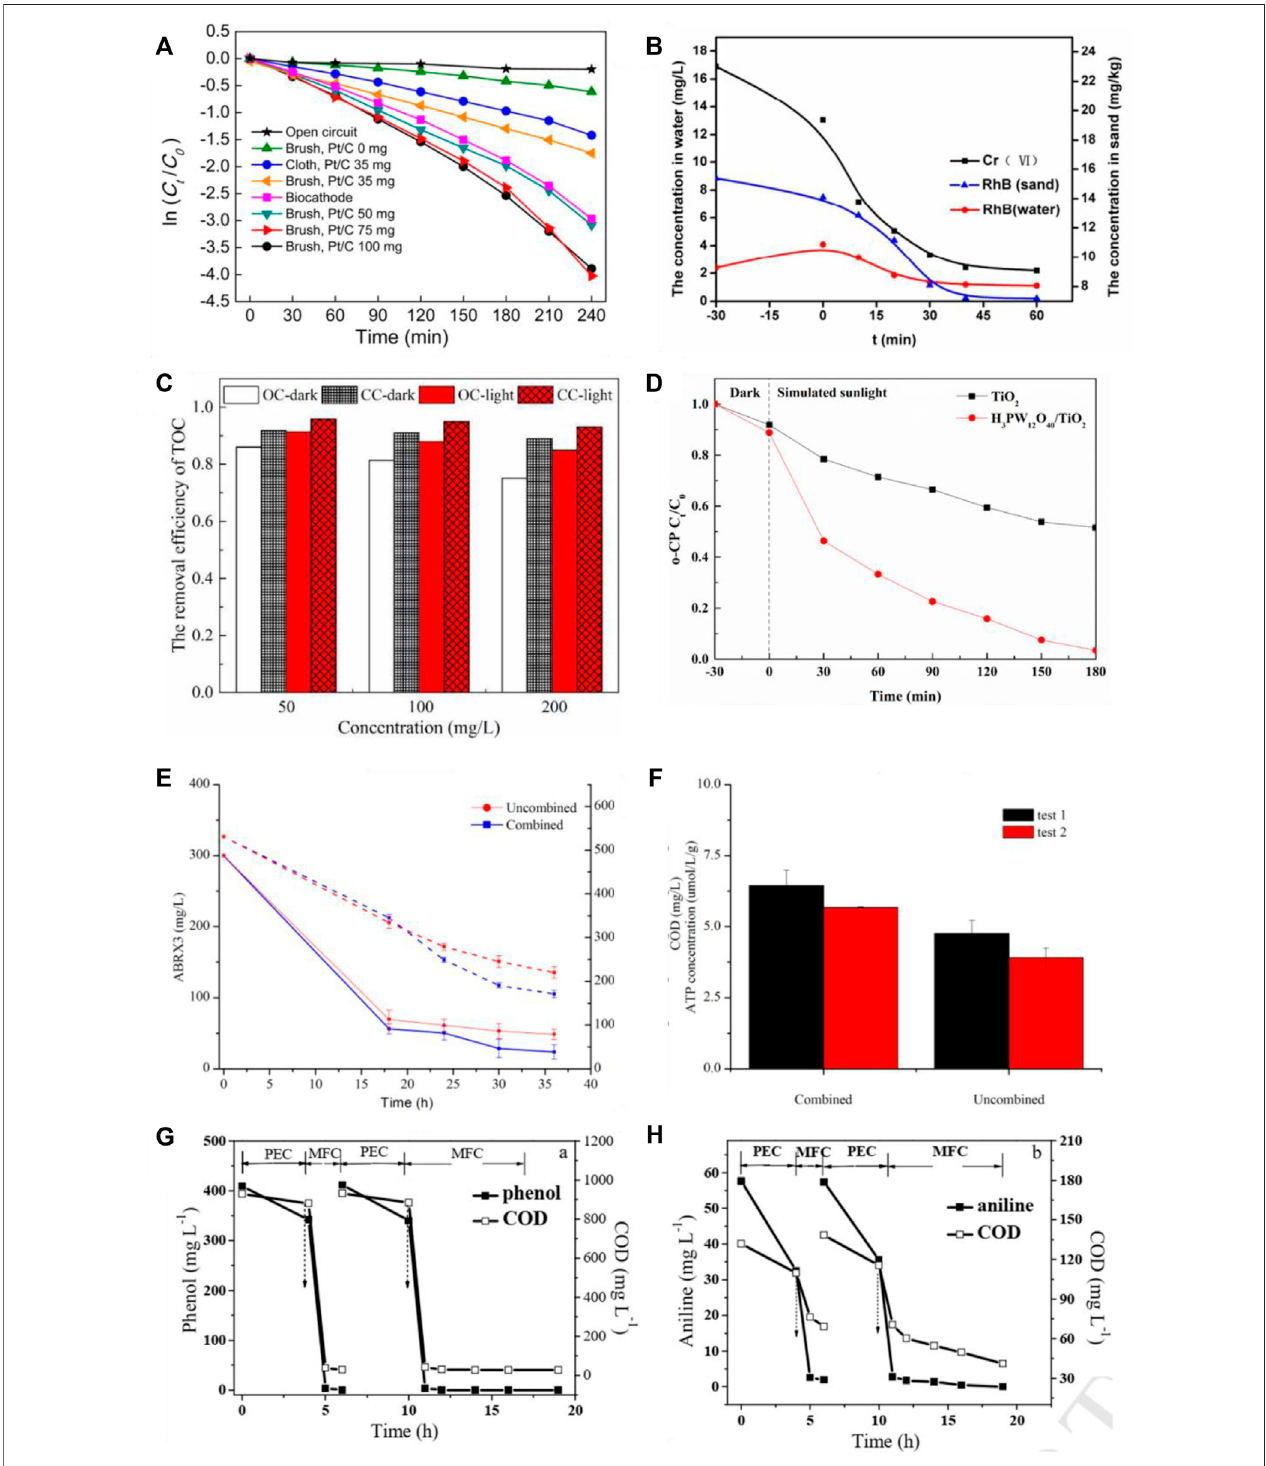
FIGURE 5 | Effectiveness of photocatalytic microbial fuelcells for the degradation of pollutants: (A) removal ofmethyl orange (Du et al., 2014); (B) removal of Cr(VI) and RhB (in water and sand) (He et al., 2018); (C) removal of 2,4,6-trichlorophenol (2,4,6-TCP) at different concentrations (Wang et al., 2019b); (D) removal of chlorophenols (Li et al., 2019b); (E) removal of azo dyes and (F) COD (Long et al., 2017); (G) Phenol and (H) Aniline removal (Zhang et al., 2019b).